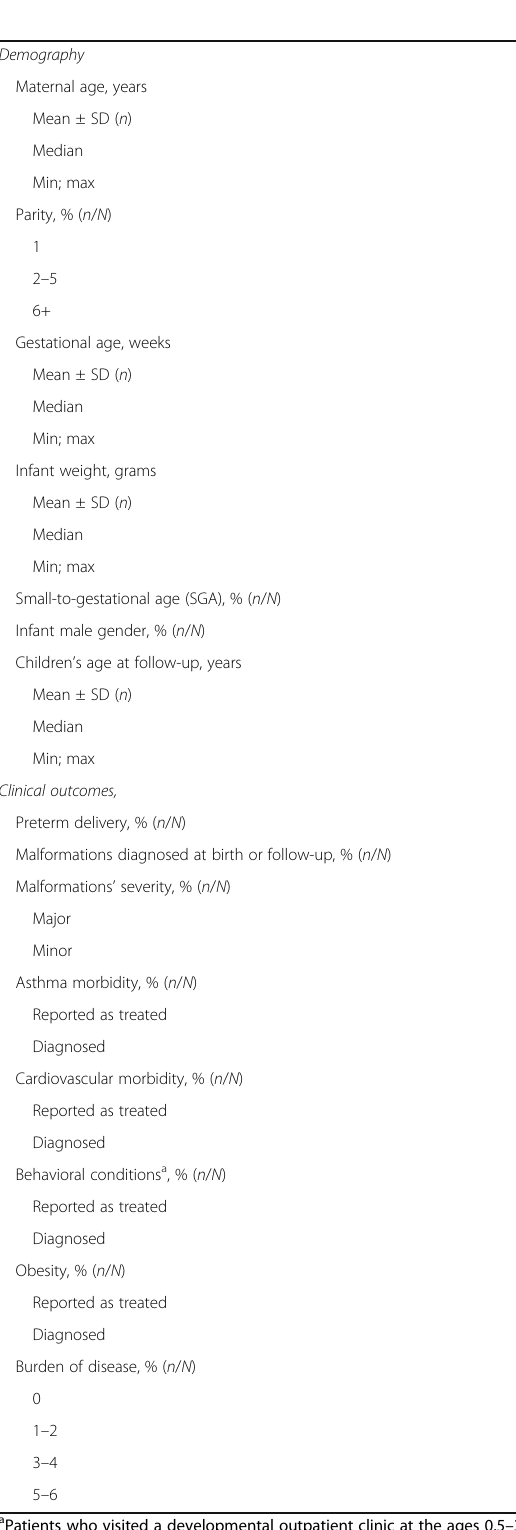
Table 1 Demographic characteristics and clinical outcomes in the study population Subjects ’